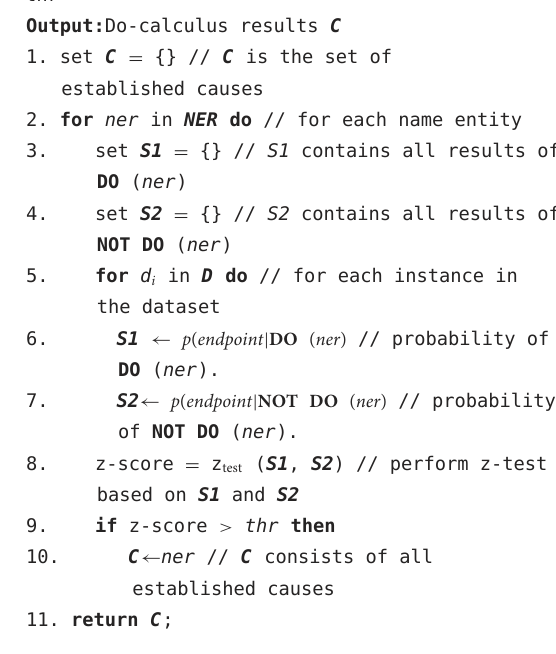
Algorithm 1. Name entity-based Do-calculus